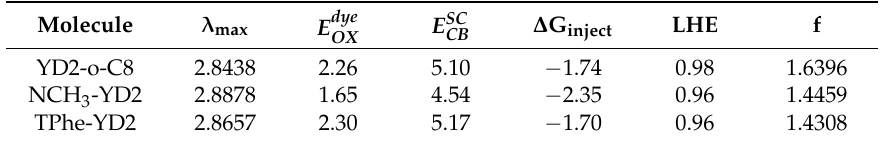
Table 6. Calculated E dye studied